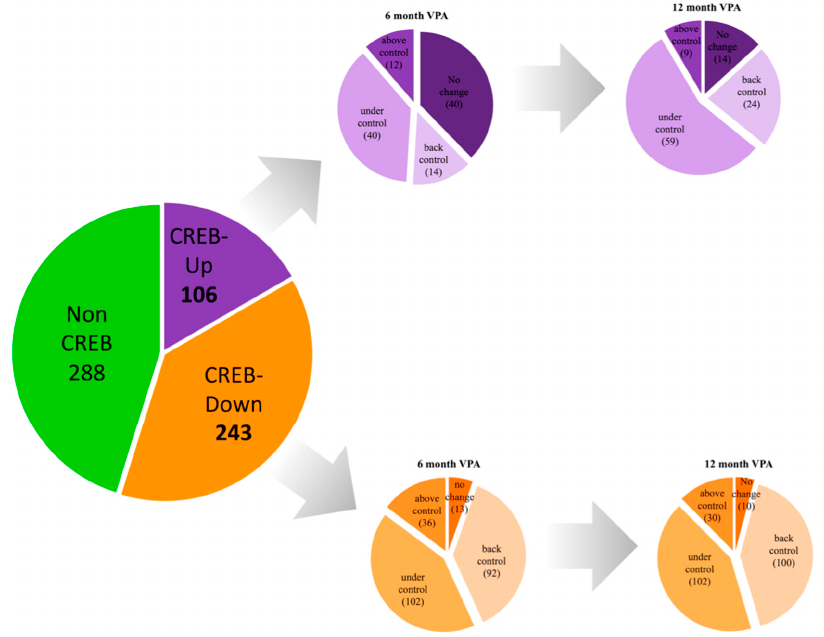
Figure 4. The image shows the profile of changes provoked by the administration of VPA (6 and 12 months) to pediatric patients with established epilepsy on the genes that depend on the transcriptional factor cAMP-response element binding protein (CREB).